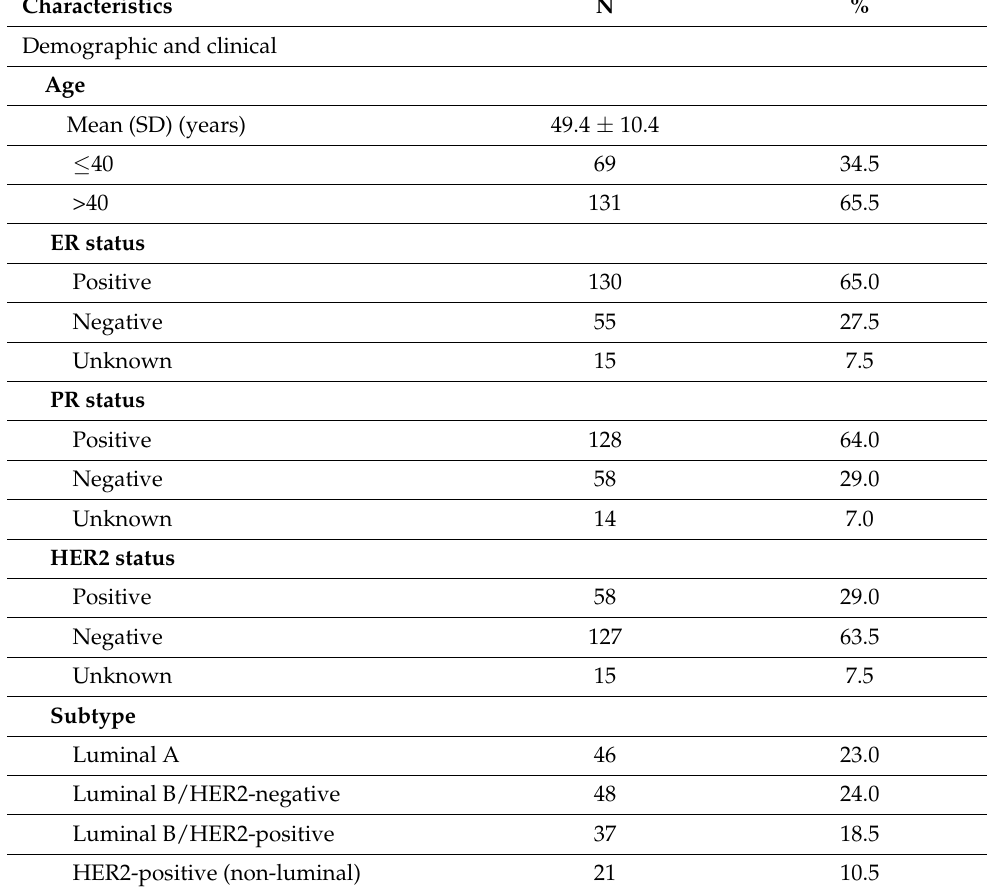
Table 1. Baseline patients’ characteristics (N